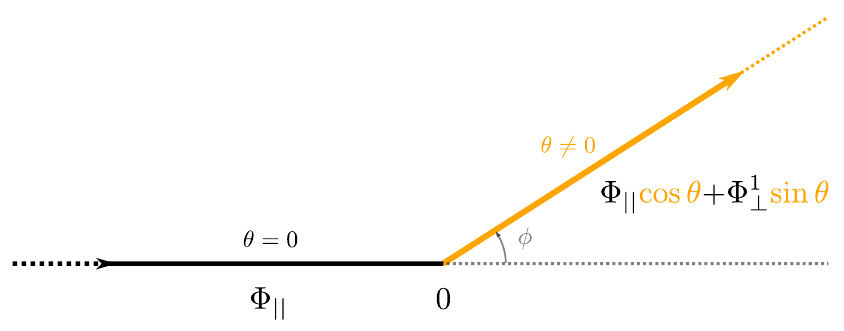
Figure 2 . The WL deformed by introducing a point-like parameter changing defect is integrable. We utilise this fact to deduce further constraints on the correlation functions of the 1D CFT on the straight